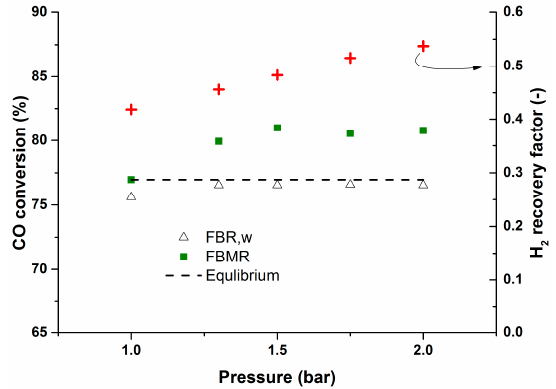
Figure 9. Membrane reactor performance for a semi-industrial inlet composition at 400 °C, CO (9.2%), H 2 O (19%), CH 4 (4%), H 2 (30%), N 2 balance, U/U mf :1.67-5, P permeate : 30 mbar